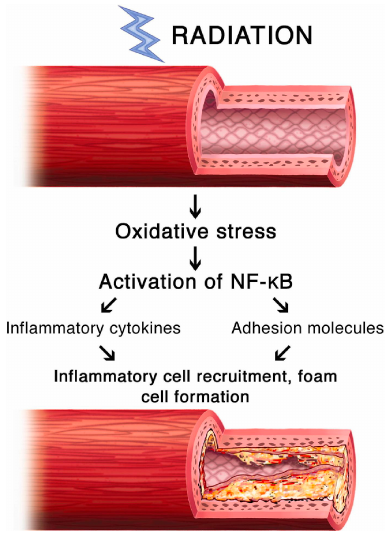
Figure 1. Mechanisms of radiation-induced cardiovascular injury. Utilized with permission from Weintraub et al. [44].